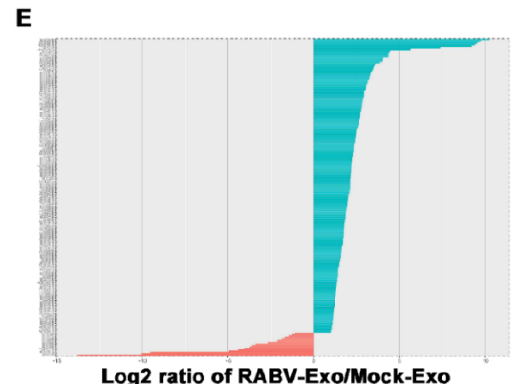
Figure 2. Characterization of exosomes and exosomal small RNA deep sequencing. ( A ) Exosomes from rabies virus (RABV)-infected MRC-5 cell culture supernatants were negatively stained with 2% phosphotungstic acid and analyzed using transmission electron microscopy. Scale bar = 100 nm. ( B ) Western blotting analysis of the isolated exosomes using the exosome-specific markers CD63 and TSG101 and the non-exosomal marker calnexin. Total RNA from RABV-infected MRC-5 cells ( C ) and exosomes released from RABV-infected MRC-5 cells ( D ) were detected using an Agilent 2100 bioanalyzer. The corresponding virtual gel images generated using the software are depicted as electropherograms. ( E ) Distribution of 232 microRNAs (miRNAs) were differentially expressed in exosomes isolated from RABV-infected and uninfected cells. A total of 215 miRNAs were detected as up-regulated (log2 > 1) and 17 miRNAs were detected as down-regulated (log2 <